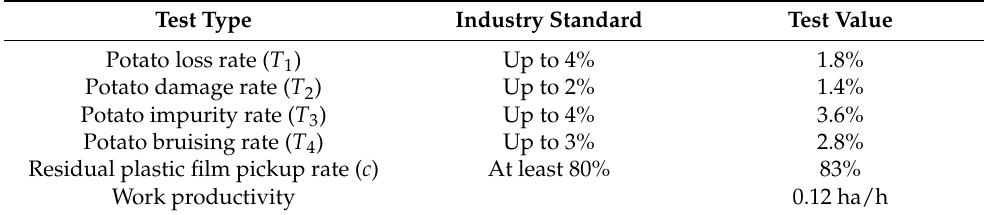
Table 2. Results of field